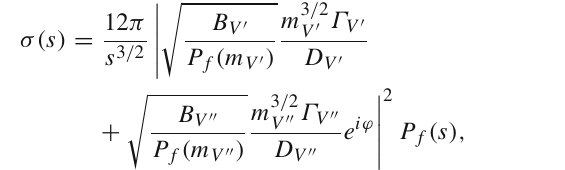
are reconstructed if their energy deposition in the calorimeter exceeds 20 MeV. A further decrease of the efficiency is due to the requirement of energy-momentum balance in an event < ( χ 2 5 γ